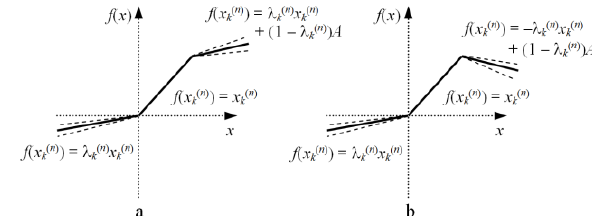
Figure 2. The bounded RL-ReLU with: